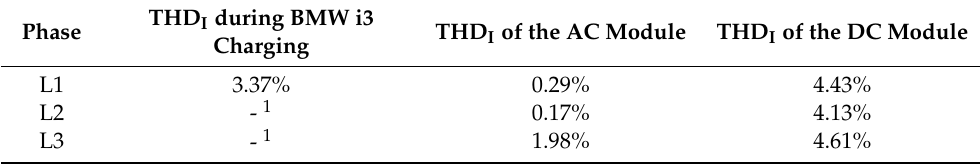
Table 1. THD I values during BMW i3 charging and during the tests of the AC and DC modules. THD I during BMW Phase